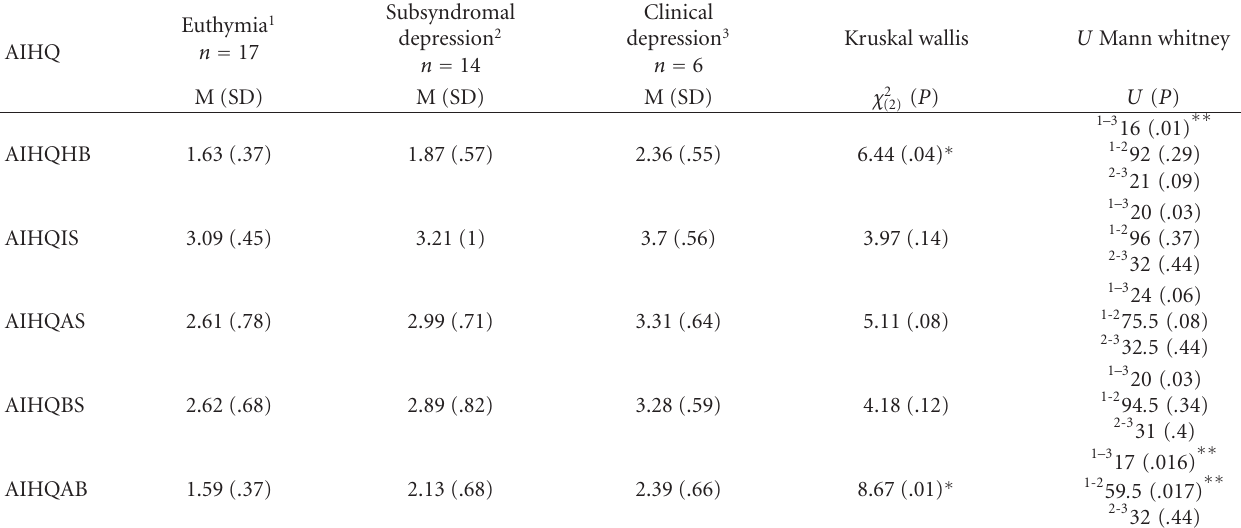
Table 4: Scores in the AIHQ subscales of the bipolar patients in state of euthymia, with subsyndromal depressive symptoms and clinical depression.